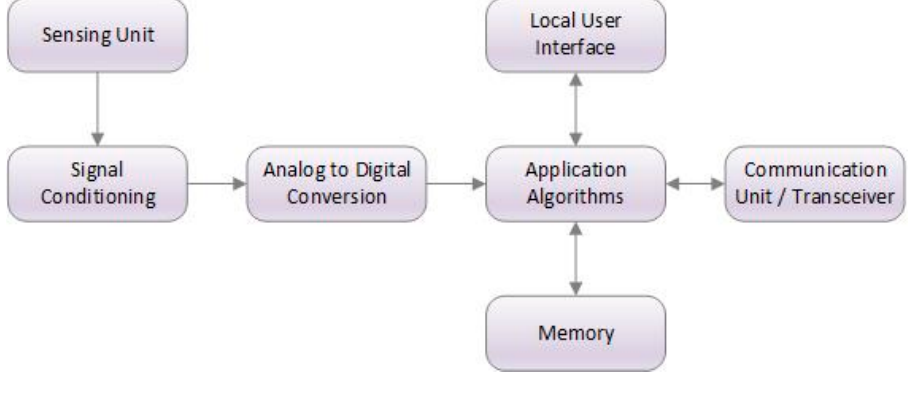
Figure 2. Smart sensor building blocks.